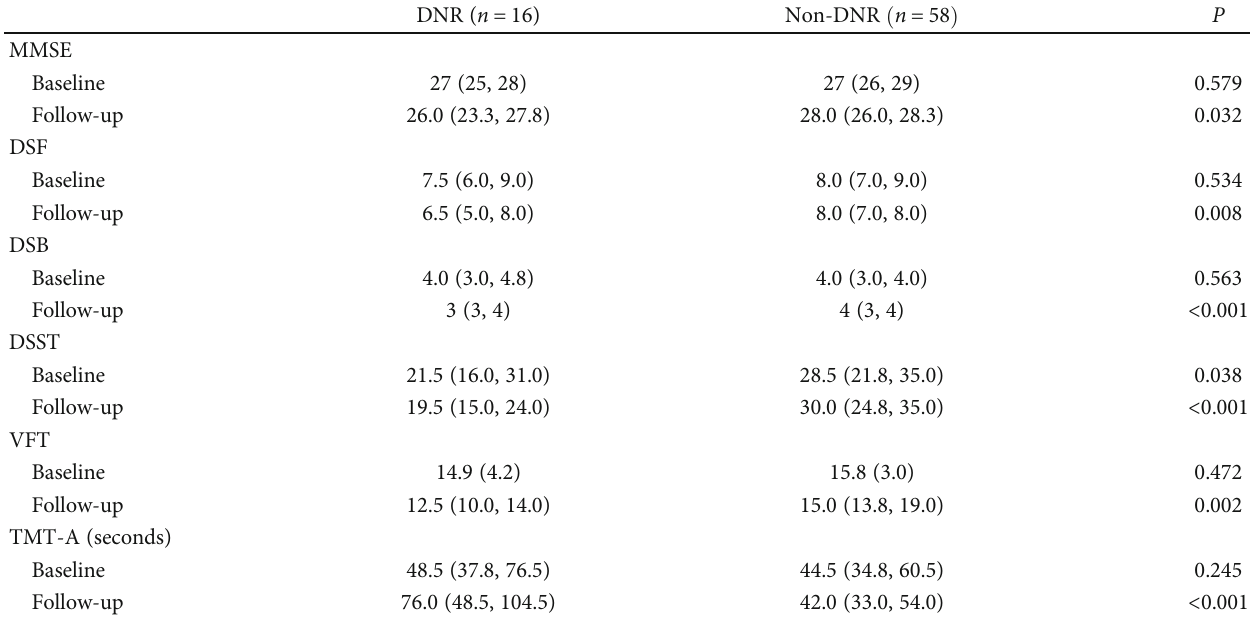
Table 2: Neuropsychological